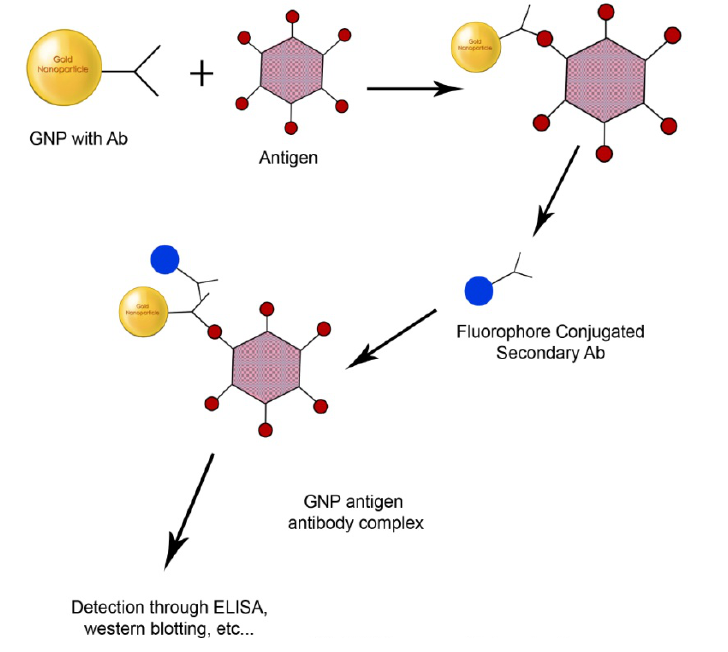
Figure 6. Antibody functionalized GNPs for use in